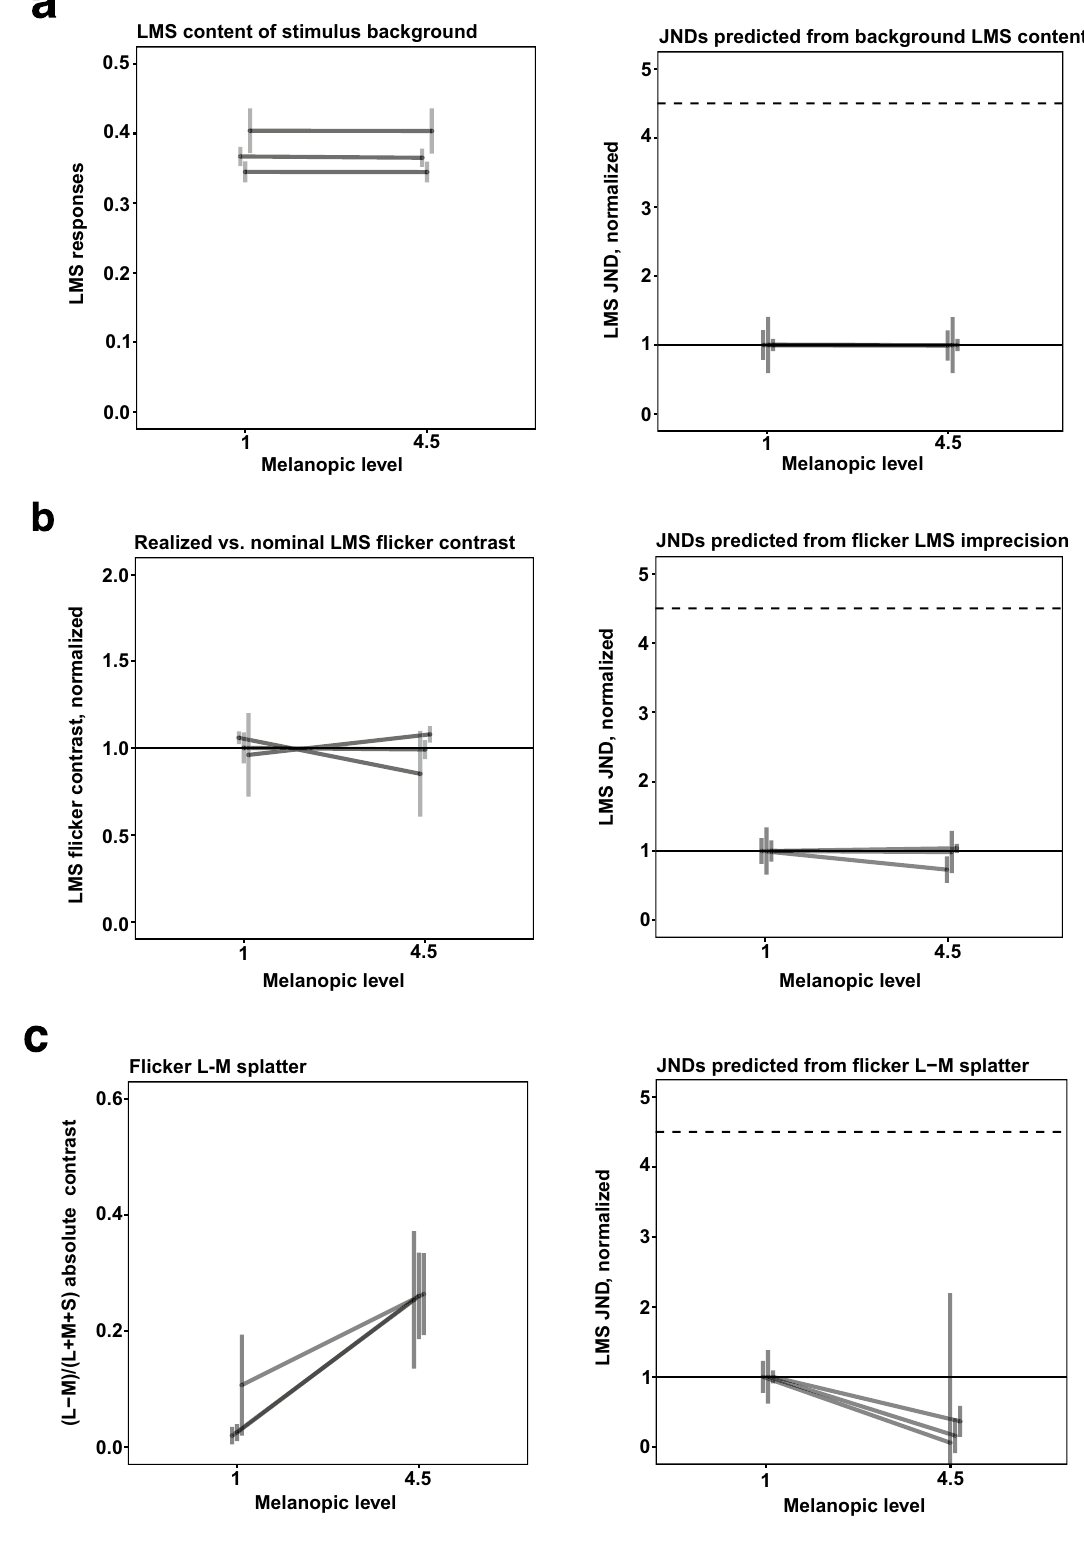
Figure 5. Stimulus imprecision analysis for Experiment 2. Same format as Fig.